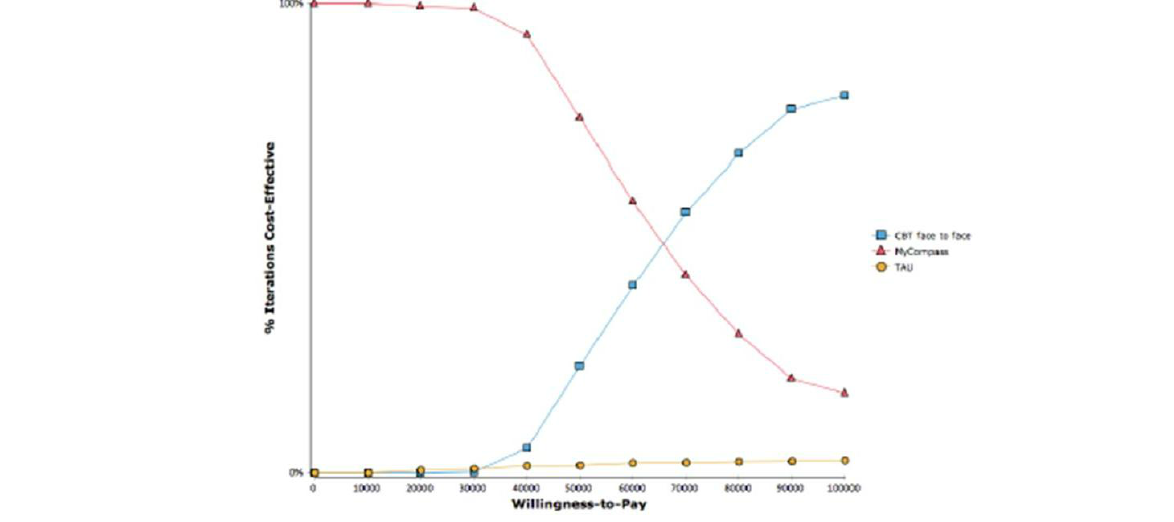
Table 5. Results of uncertainty analysis.